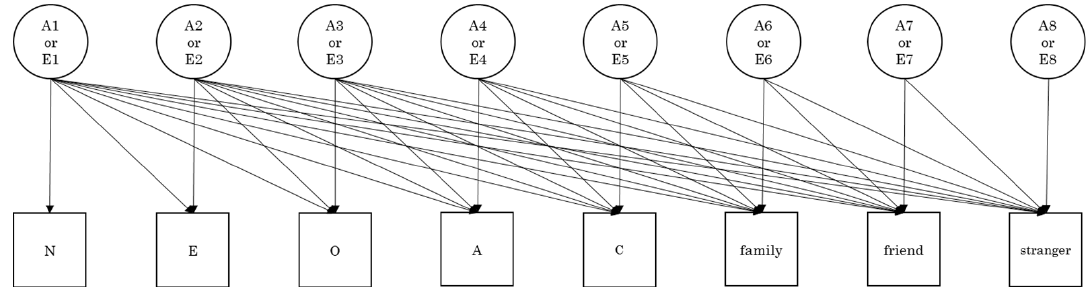
Figure 2. Cholesky decomposition model analyzing genetic and environmental relationships between three types of altruism and big five personality dimensions (N = neuroticism, E = extraversion, O = openness to experience, A = agreeableness, C = conscientiousness). Full (saturated) model was employed for additive genetic (A) and non-shared environment (E) factors (not shown in this figure but the same as A). A reduced model was employed for shared environment factors based upon the results of univariate and common pathway models.